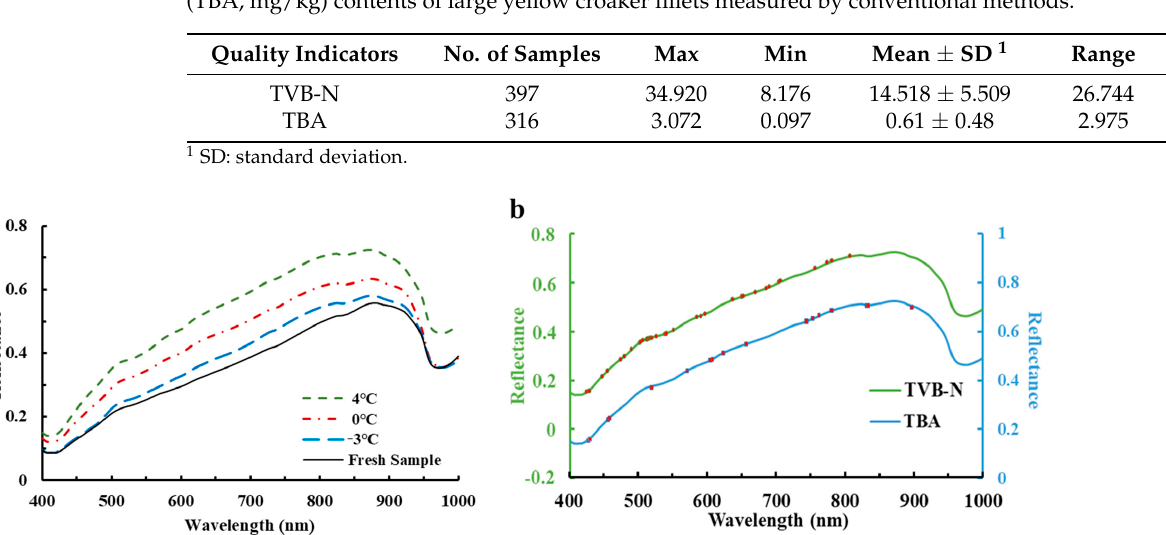
Table 1. Reference results of total volatile basic nitrogen (TVB-N, mg/100 g) and thio-barbituric acid (TBA, mg/kg) contents of large yellow croaker fillets measured by conventional methods.